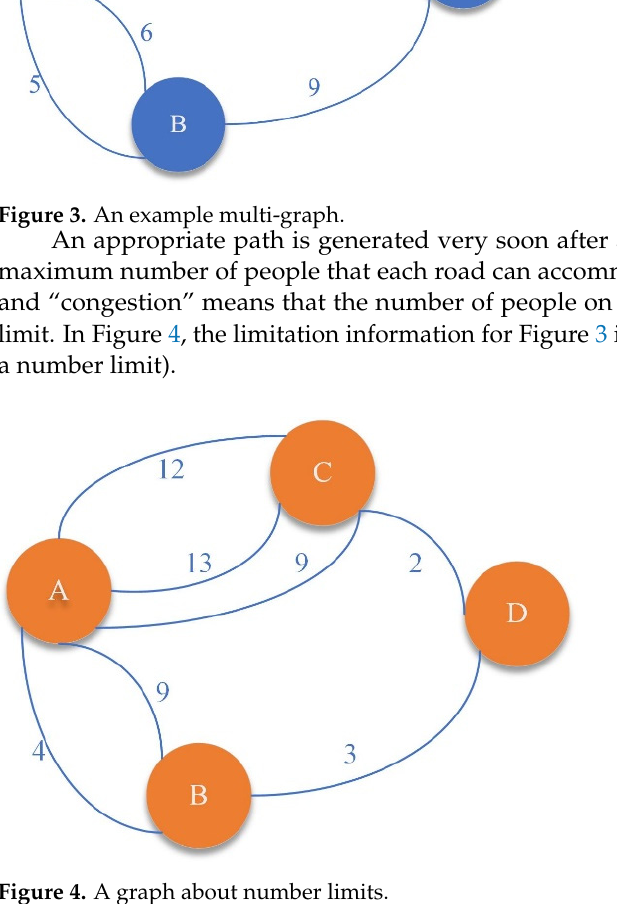
Figure 4. A graph about number limits.